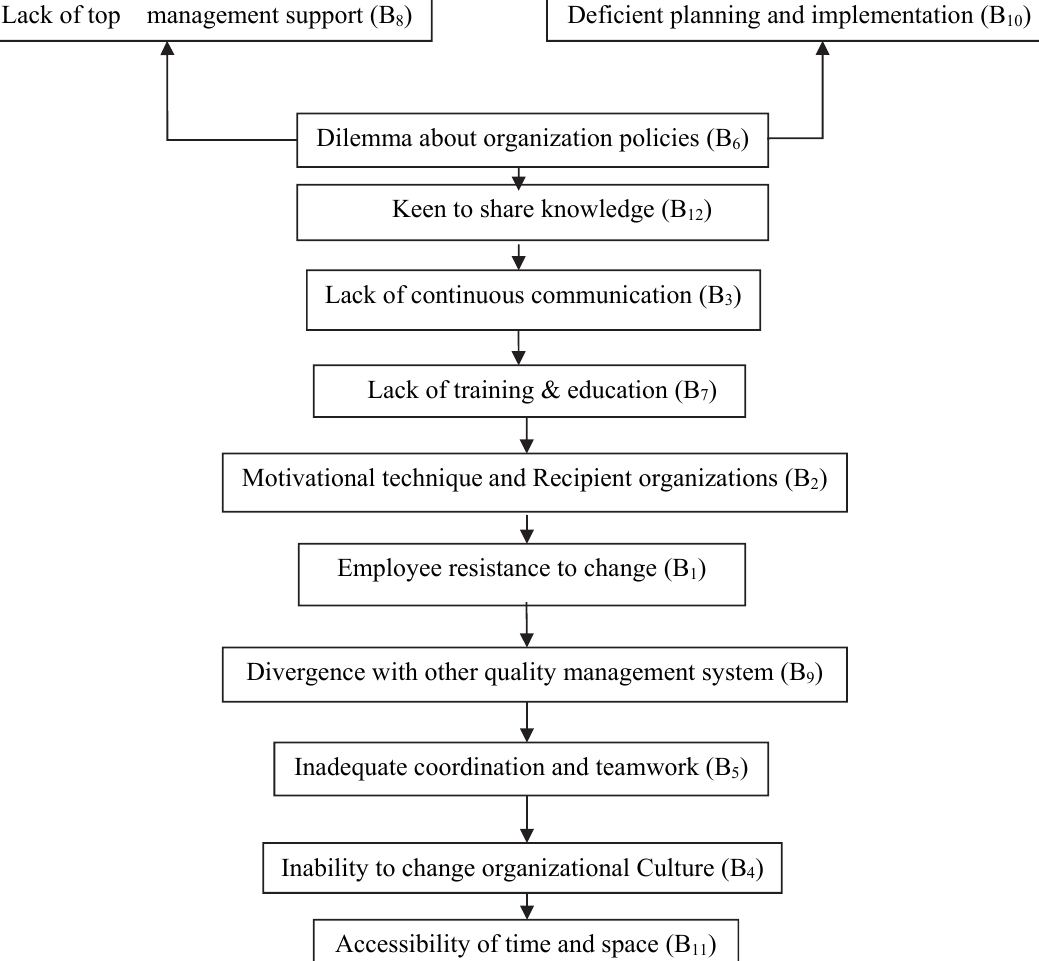
Fig. 5. Integrated model of barriers affecting manufacturing organization